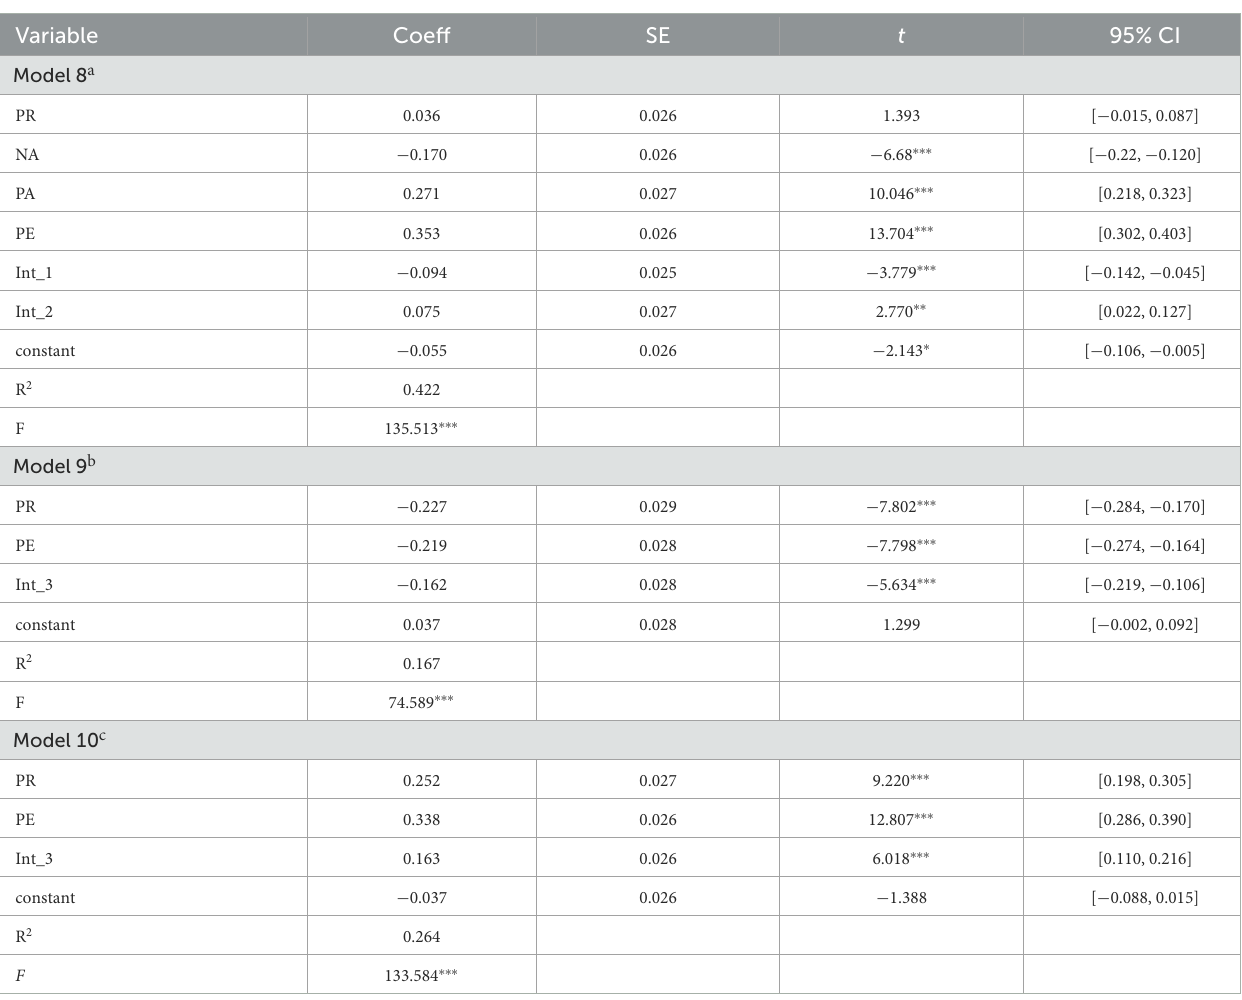
TABLE 5 Standardized coefficients for the moderated mediation